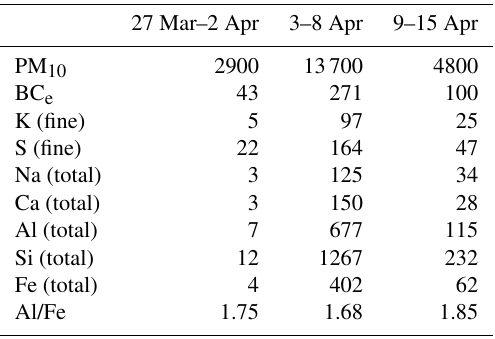
Table 1. Element concentrations in aerosols measured at the ZF2 rainforest site before, during, and after the dust event of 3– 8 April 2015 (in ngm − 3 ) . Potassium and sulfur are in the fine frac- tion (<2.5µm); the other concentrations are in PM 10